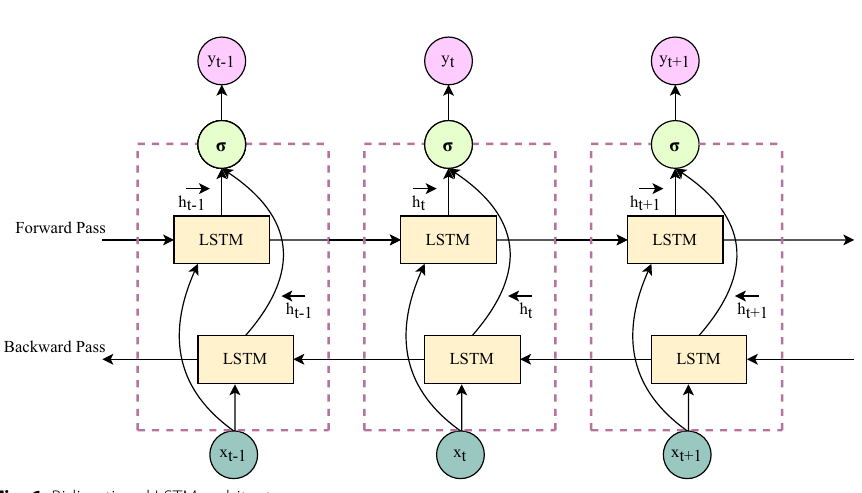
Fig. 6 Bidirectional LSTM